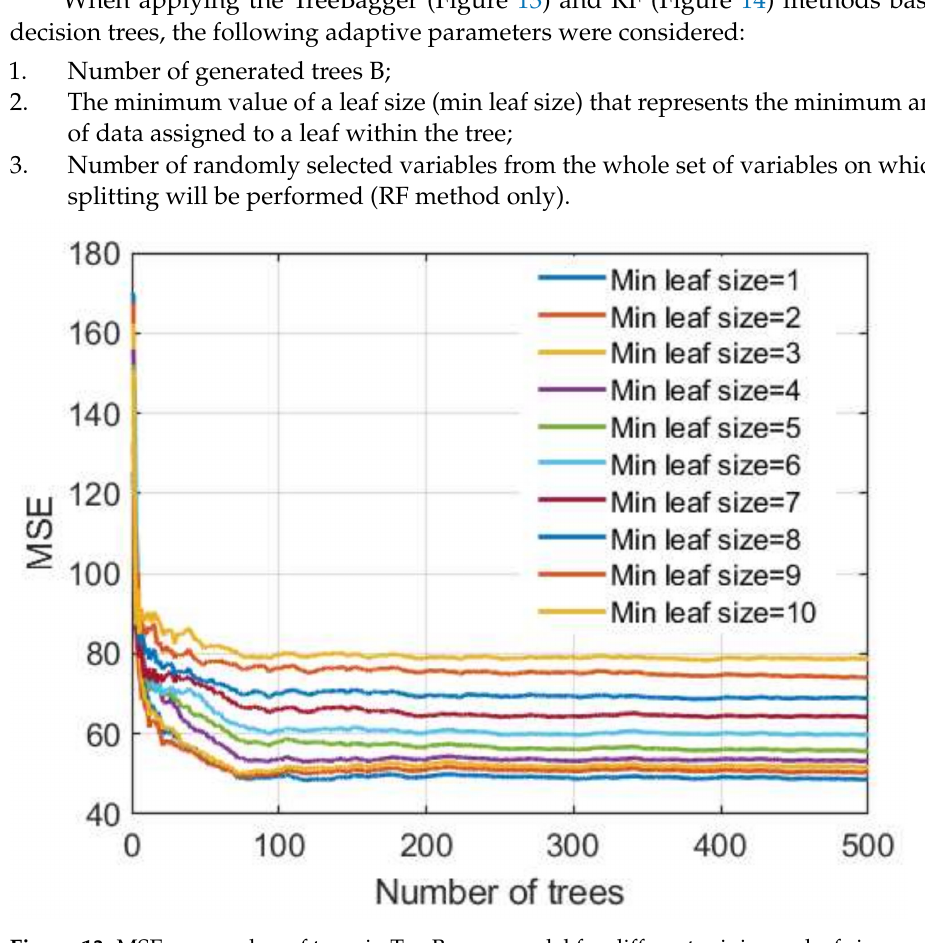
Figure 13. MSE vs. number of trees in TreeBagger model for different minimum leaf